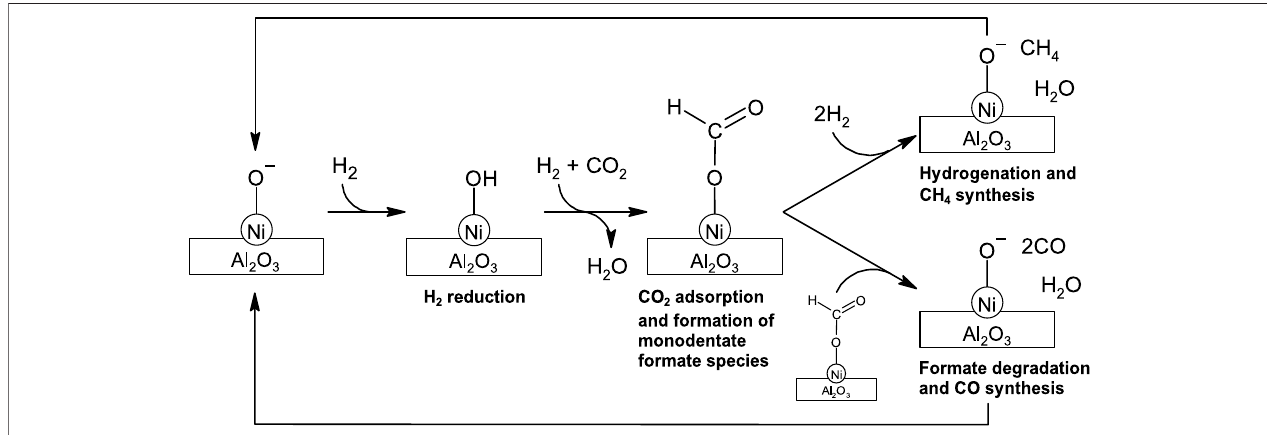
FIGURE 1 | Scheme of reaction mechanisms of Ni/Al 2 O 3 catalyst in CO 2 methanation (Cárdenas-Arenas et al., 2020).